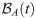
Influence of budget restrictions.The time evolution of the fractions of persuadable nodes a0(t), b0(t), activists a+(t), b+(t), empty nodes o(t) as well as the budgets BA(t) and BB(t). The shown curves are the results of a stochastic simulation on a random regular network with N = 105 nodes, k = 10 and the following initial conditions: a0(0) = 0.54, b0(0) = 0.01, a+(0) = 0.1, b+(0) = 0.15 and o(0) = 0.2. The convincing probabilities are fixed to ρA = ρB = 1 and the costs to cA = cB = 2. The thick grey curves are the numerical mean-field solutions of Eq (2). In the left panel, the budgets are exhausted after some time due to the small initial values BA(0)=2 and BB(0)=2, and thus the evolution changes. On the other hand, in the right panel, the initial budgets BA(0)=8.4 and BB(0)=9.1 are chosen to be large enough not to influence the evolution during the given time horizon.